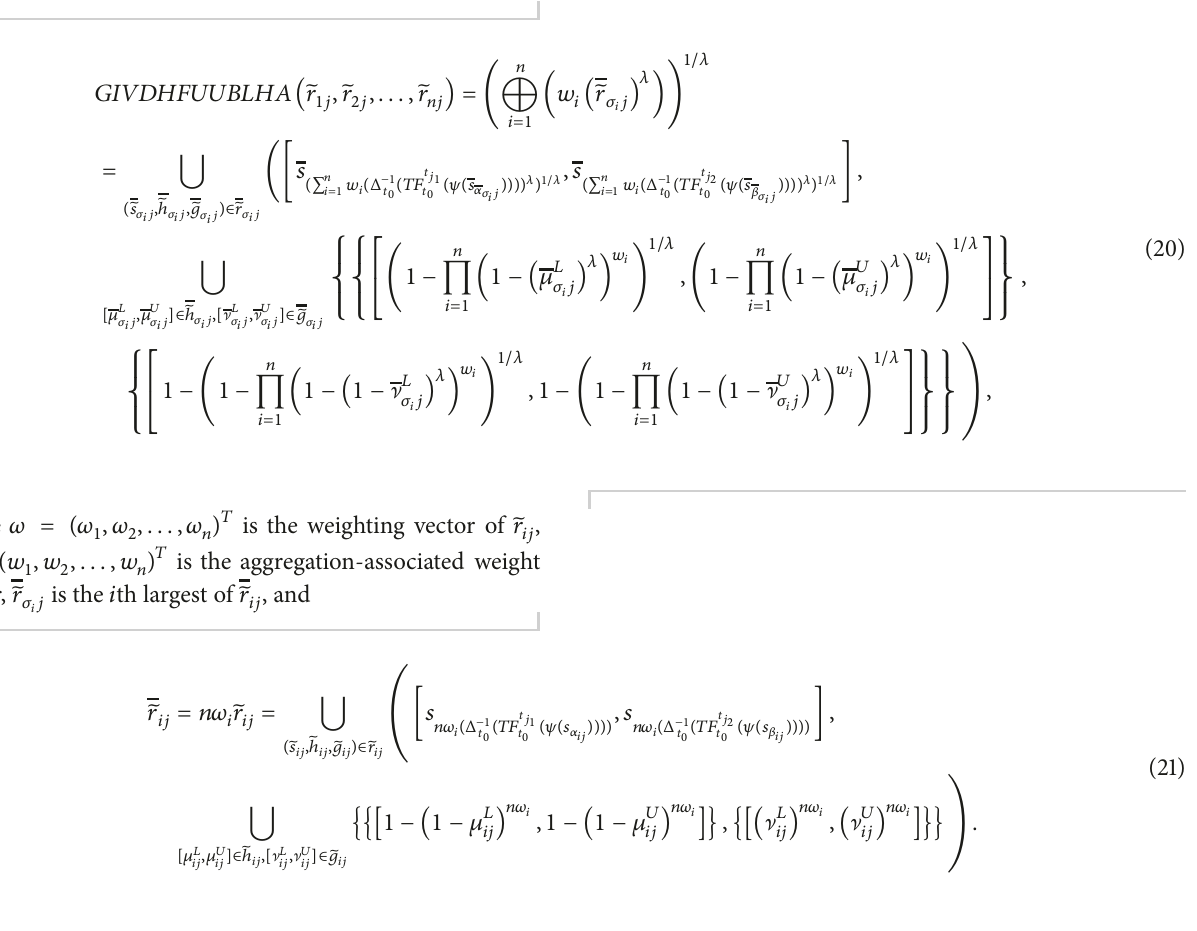
Algorithm I. Hesitant fuzzy linguistic MADM with attributes interdependency and decision-makers’ group attitudinal